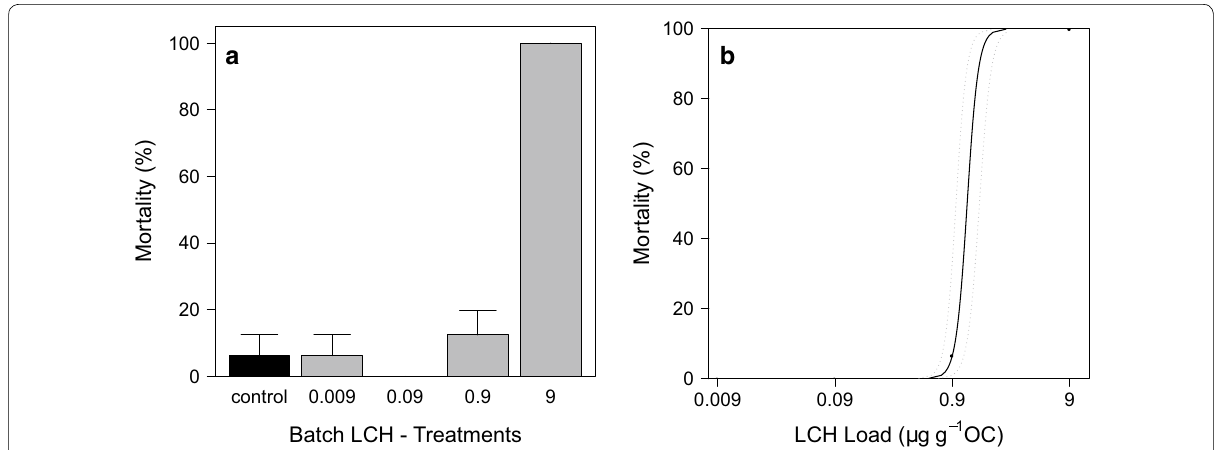
Fig. 8 a Grazer mortality at the end of the LCH AIS [mean, n 1] and b Concentration response relationship calculated using Probit model after = correction of control mortality according to Abbott. Dotted lines indicate the 95 % confidence level. Treatment names according to the nominal LCH loads in µg g − 1 OC as described in Table 1